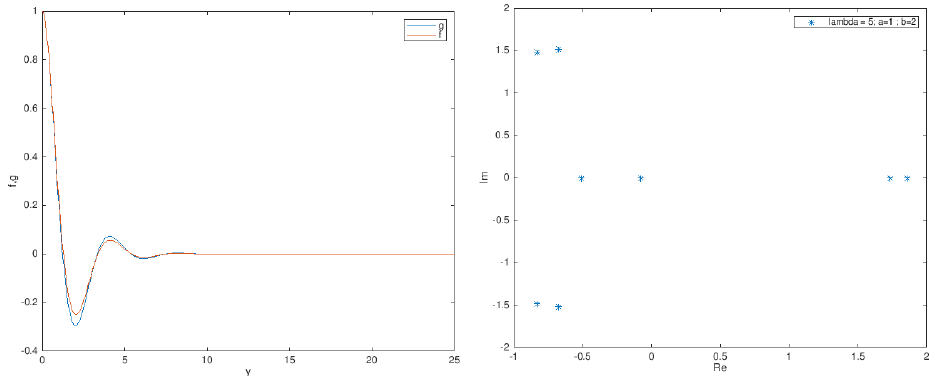
Figure 14. TW evolution and Homotopy graph for a = 1, b = 2, λ = 5.